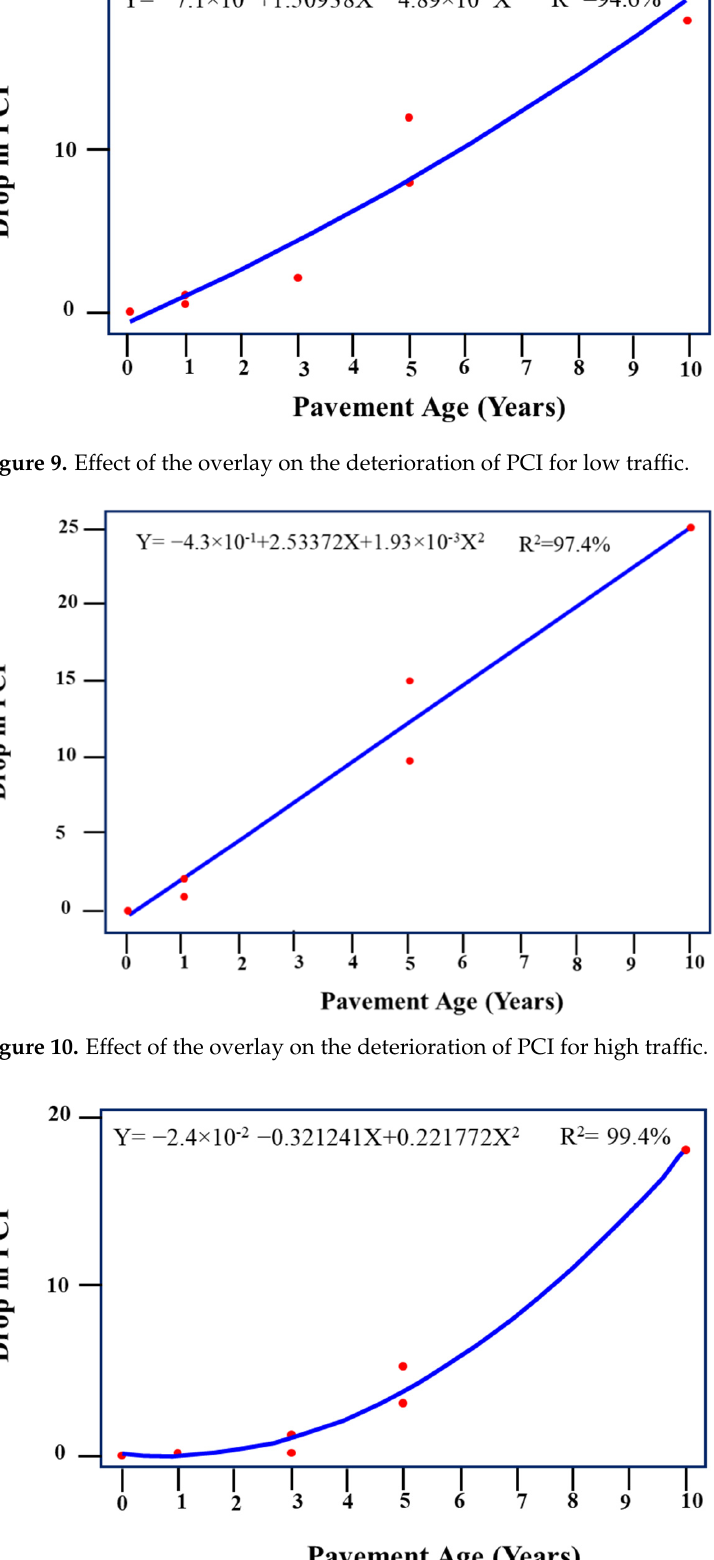
Figure 11. Effect of reconstruction on the deterioration of PCI for low traffic.